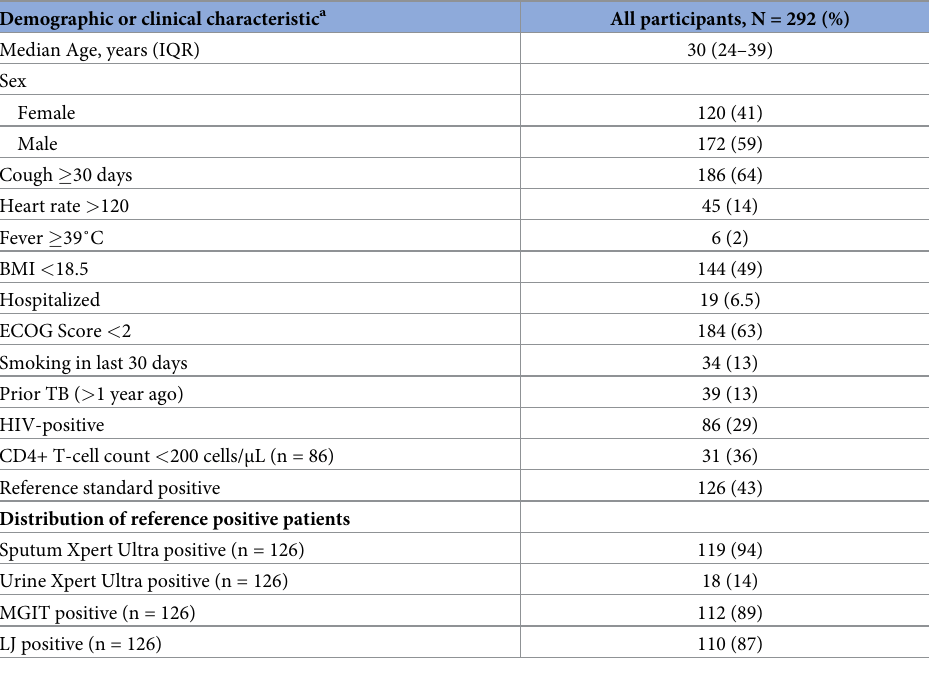
BMI: Body Mass Index; ECOG: Eastern Cooperative Oncology Group; IQR: Interquartile Range. a n = 292 unless indicated.